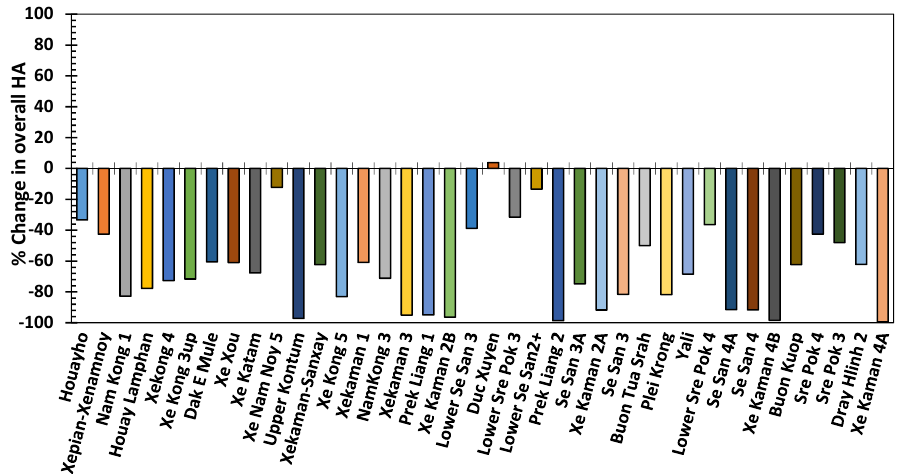
Figure 9. Percentage changes in overall HA due to operation of hydropower reservoirs under seasonal variation rule curves with respect to operation of reservoirs under full supply level rule curves for the baseline climate (BLR) scenario.